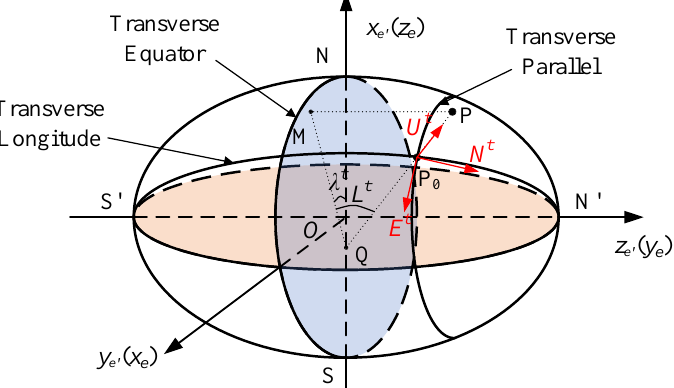
Figure 1. Definition of the transverse frame.